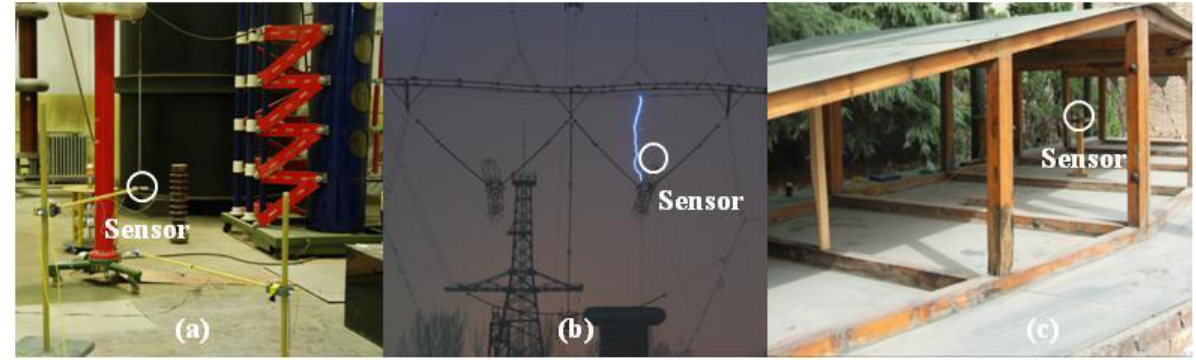
Figure 1. Intense E-field measurement in ( a ) a 1 m rod-plane air gap; ( b ) a window of an ultra-high voltage transmission tower; and ( c ) a NEMP